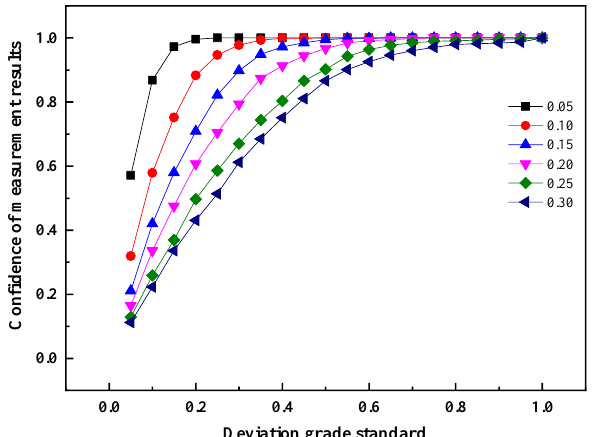
Figure 35. Relationship between deviation grade standard and confidence of measurement results under different relative standard deviation of velocity at mean velocity 4.3 m/s.